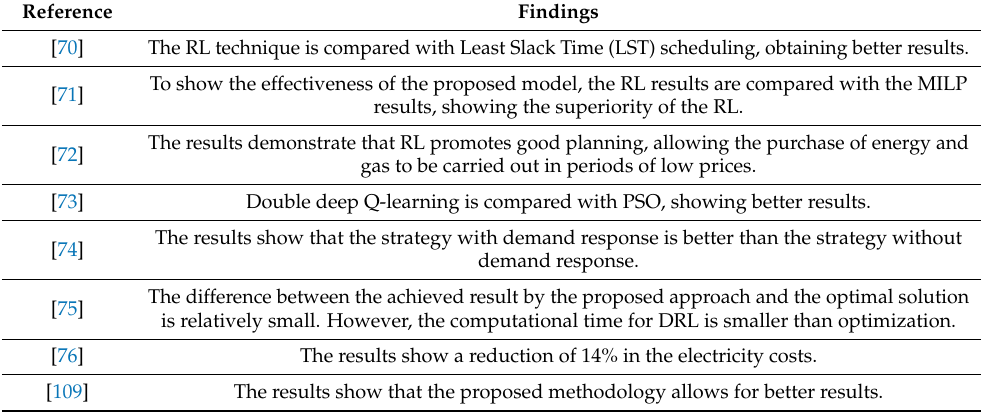
Table 15. Findings of selected papers associated with reinforcement learning.